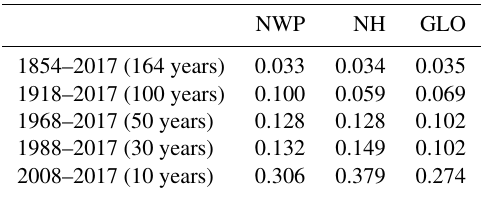
Table 1. The average trend of SST (unit: ◦ C/10